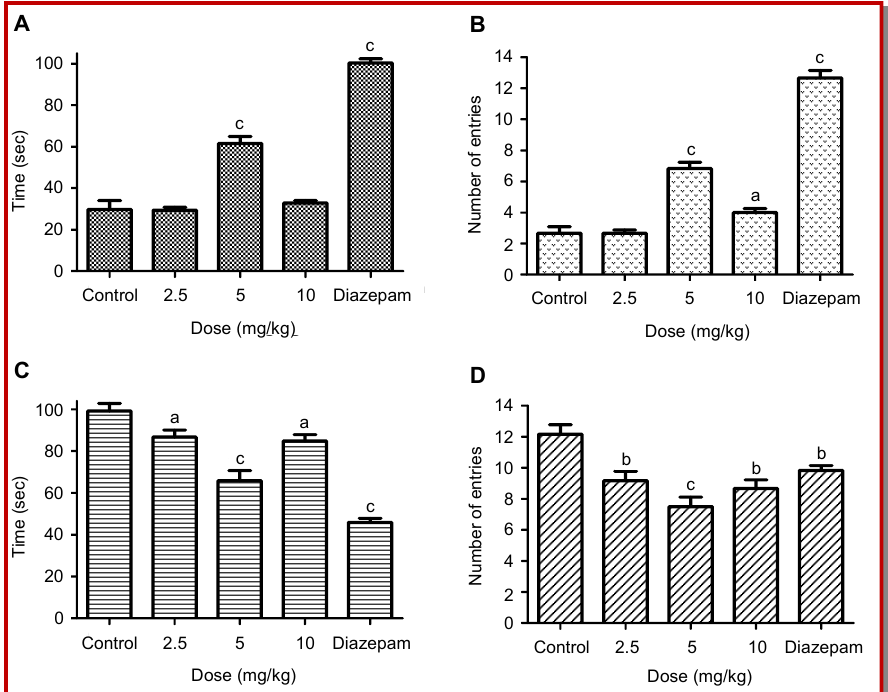
Figure 2: Effect of n -hexane fraction of C. annum, at test doses in elevated plus maze model. Time spent in open arm (A), Number of entries to open arm (B), Time spent in close arm (C), Number of entries to closed arm (D). Control (Saline and Tween 80 2.5%), 2.5,5,10 mg/kg ( n -hexane fraction of C. annum ), and diazepam 1 mg. All values are expressed as mean ± SEM; n = 6; a p<0.05, b p<0.01, c